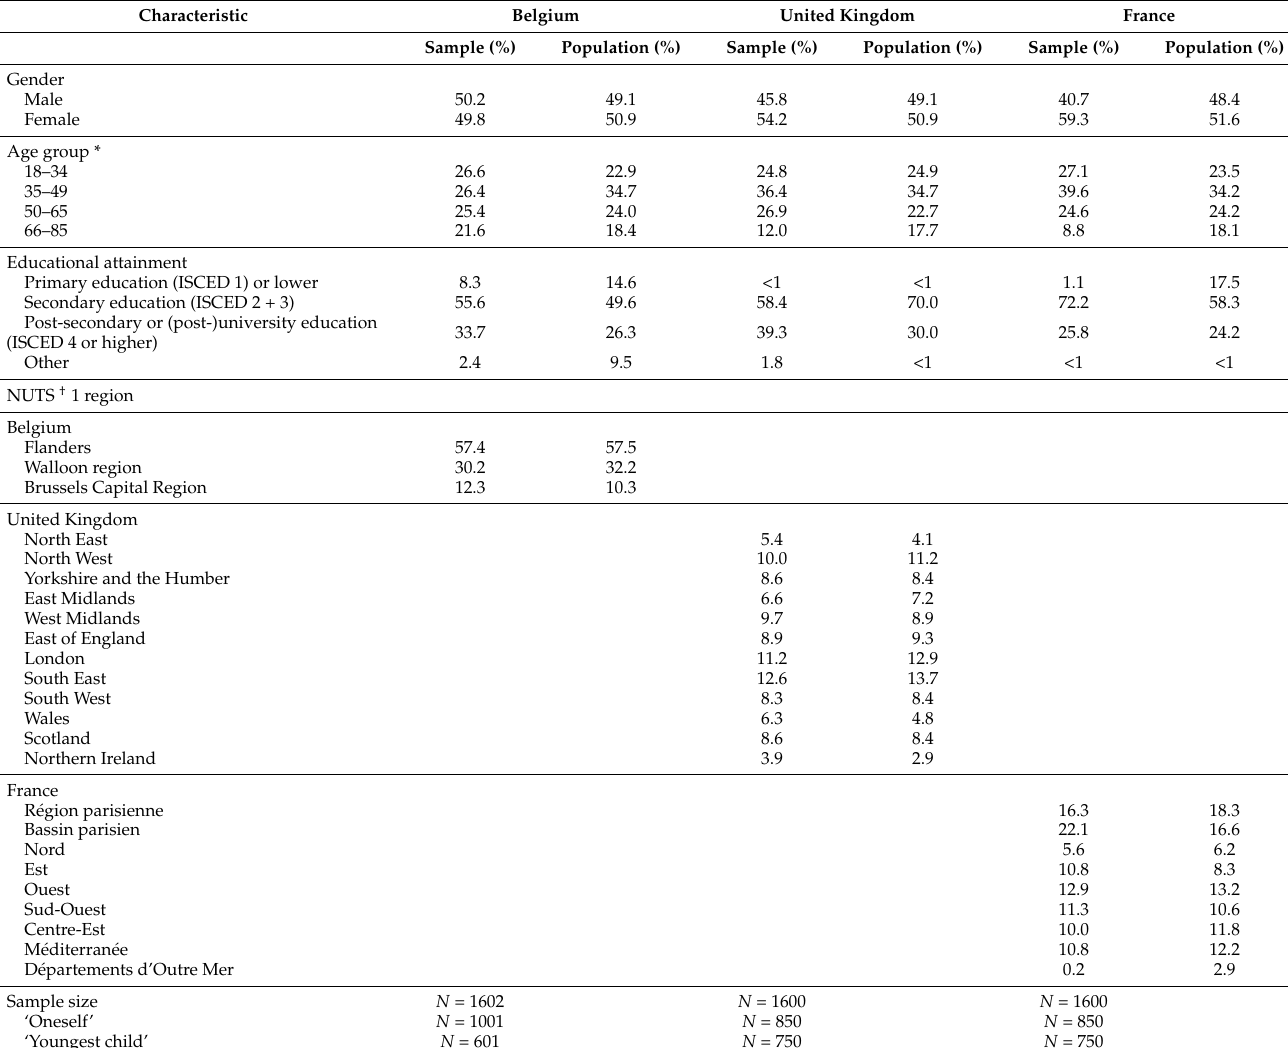
Table 1. Sample characteristics and national statistics for Belgium, France & The